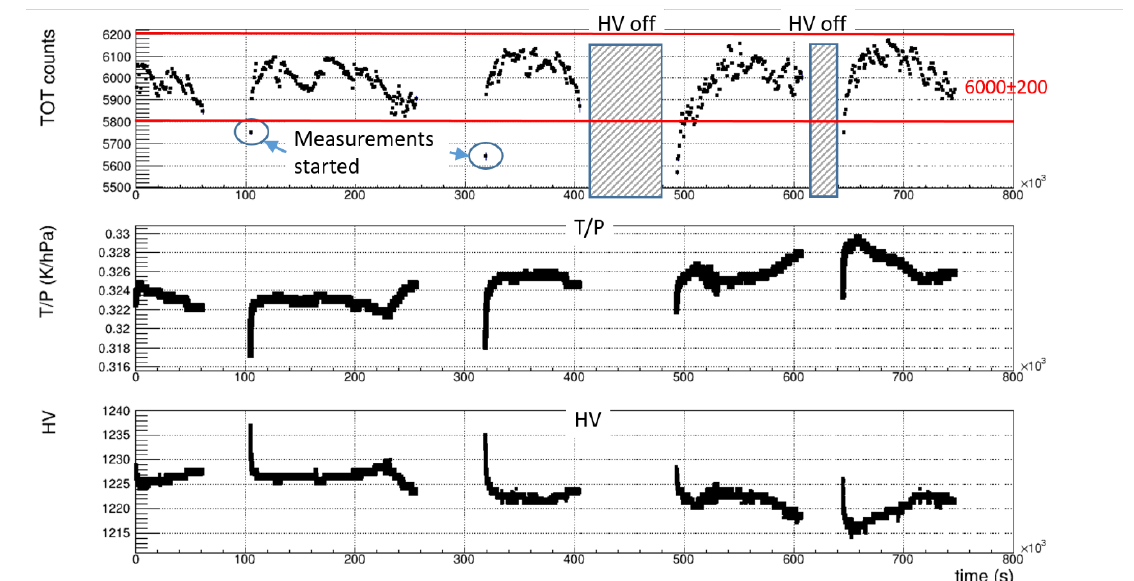
Figure 5. Measurement with an 55 Fe source over nine days. The plots show the time evolution of the ToT counts of the 5.9 keV peak from 55 Fe ( top plot ), the ratio temperature/pressure (T/P) ( middle plot) , and the High Voltage (HV, lower plot ). The ToT counts are within 6000 ± 200 if measurements in the heat-up phase of the detector (‘fast rising T’) and after the HV was off are discarded.